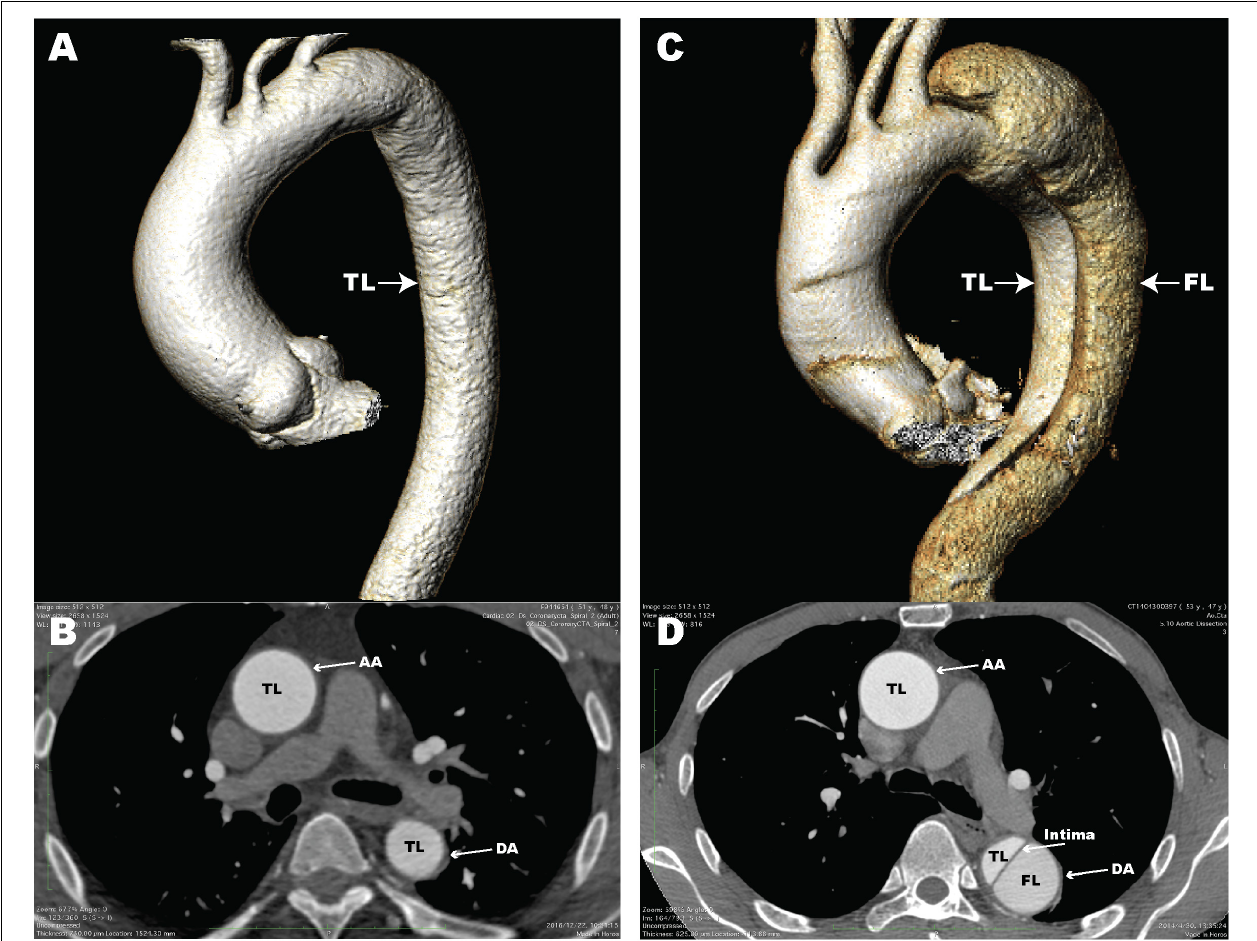
FIGURE 1 | Computed tomography angiography (CTA) images of a normal aorta and an aortic dissection (AD). (A) 3D reconstructed CTA image of a normal aorta; (B) Axial CTA image of a normal aorta with blood flow only in the true lumen (TL); (C) 3D reconstructed CTA image from a patient with AD; (D) Axial CTA image of AD with blood flow in both the true lumen and false lumen (FL). The aortic intima is located between the TL and FL. AA, ascending aorta; DA, descending